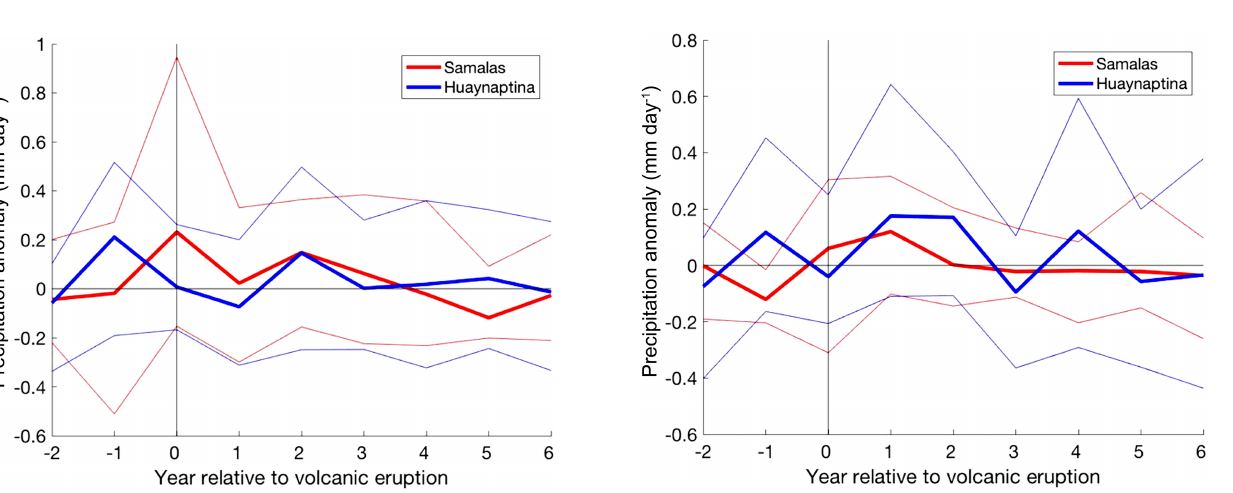
Figure 9. Multi-ensemble and multi-volcano mean NW Australian precipitation (mmday − 1 ) response to CR and “None” forcing groups and multi-volcano mean to the 2 × G forcing group in the eight years surrounding eruption over JASON. Significance was tested using the 0.6 standard deviation threshold (horizontal blue lines), and by comparing the CR and 2 × G ensembles to those with- out volcanic forcing.